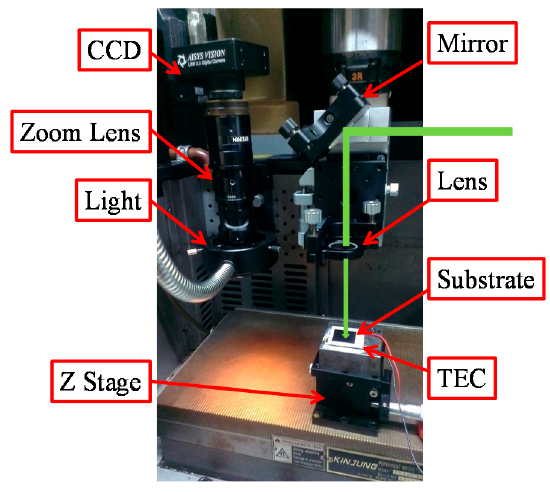
Figure 3. Picture of the experimental setup.